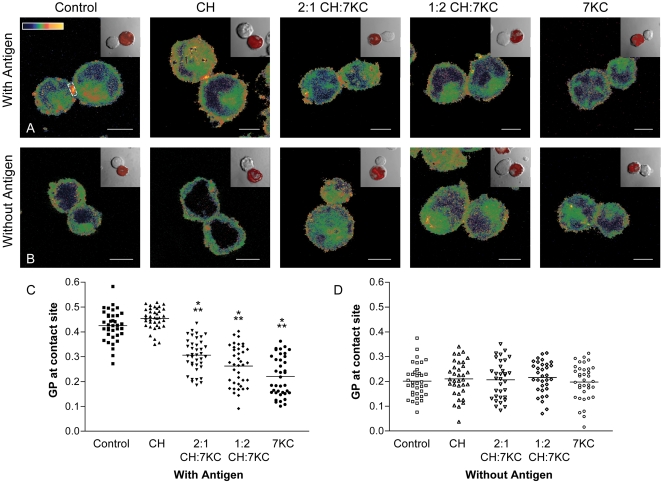
Membrane structure at immunological synapses in sterol-enriched T cells.Jurkat 8.2 T cells were treated without sterols (control), cholesterol (CH), 2:1 CH:7KC, 1:2 CH:7KC or 7KC alone as described in
Methods
. Sterol-enriched, Laurdan-labeled Jurkat 8.2 cells were conjugated to CMRA-labeled B cells for 7 min in the presence (with antigen, A, C) or absence (without antigen, B, D) of 2 μM antigen cytochrome c. A–B. Cell couples were fixed, imaged and intensity image converted into GP images and pseudo-coloured (scale in A) as described previously. Inserts show the corresponding transmission image with the orange fluorescence of CMRA overlaid to identify APCs. Bar 5 μm. C–D. GP values were measured over the entire contact area between T cell-APC couples as indicated in A. Means (indicated by horizontal lines) and SDs are shown in Table 1. In C, differences (P<0.05) were found between the means of all conditions except between control versus cholesterol and 1:2 CH:7KC versus 7KC. No differences were found in D. Difference of P<0.05 compared to control cells are marked with one asterisk; differences of P<0.05 to cholesterol-enriched cells with two asterisks.